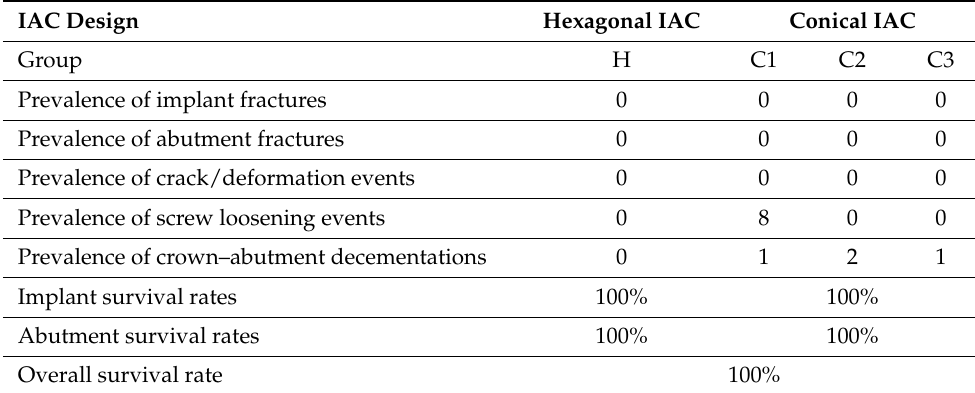
H = implants with internal hexagonal connection; C1, C2, C3 = implants with internal conical con- nection.